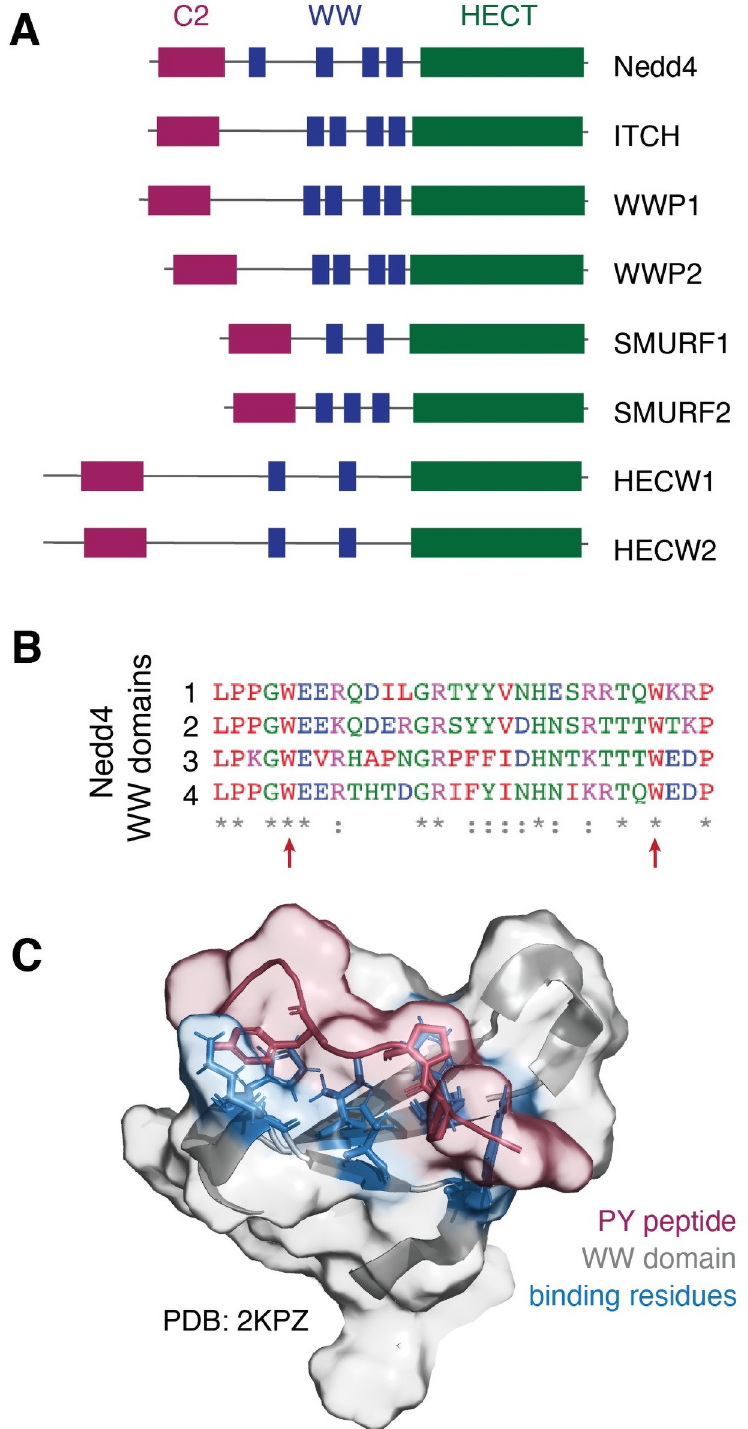
Fig 1. The Nedd4 family of ligases contains conserved WW domains for interactor recognition. (A) Nedd4 and related ligases contain 2–4 WW domains that recognize interactors containing a PY motif (PPxY, LPxY) or phosphorylated threonine or serine residues. (B) Alignment of the four WW domains from prototypical member Nedd4 shows moderate sequence similarity and highlights conserved residues, including the two characteristic tryptophan residues (indicated by red arrows). (C) Solution state NMR structure of the Nedd4 WW domain 3 (grey)